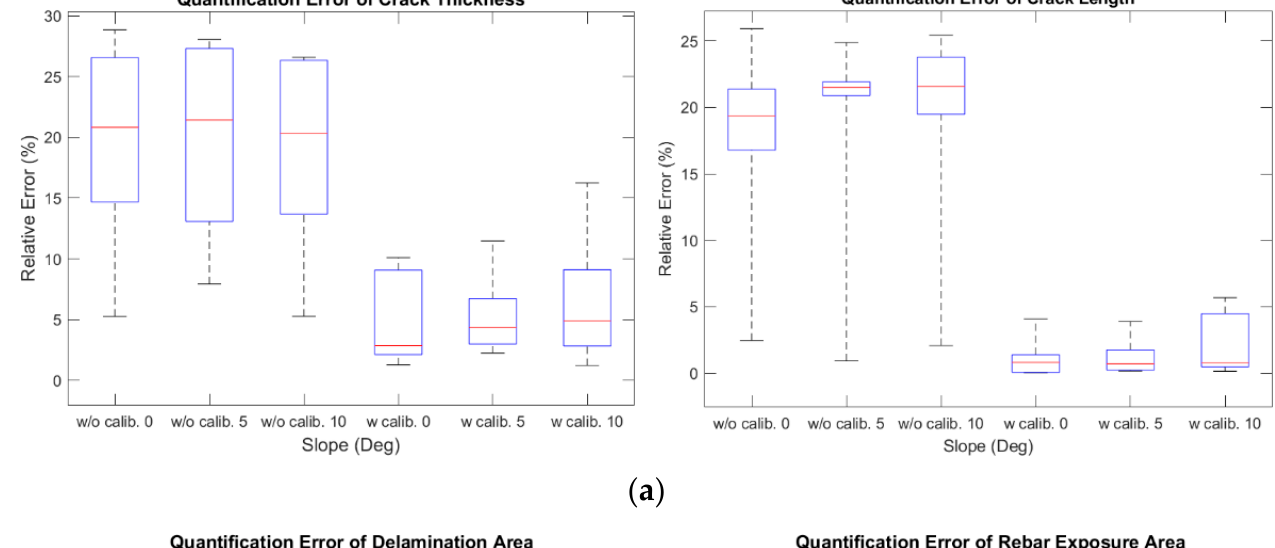
12 of 15 ( c ) Figure 10. The captured images with the slope of: ( a ) 0 degrees; ( b ) 5 degrees; and ( c ) 10 degrees. Table 3. Relative error of quantification results according to slope (0, 5, and 10 degrees). Slope (Deg.)